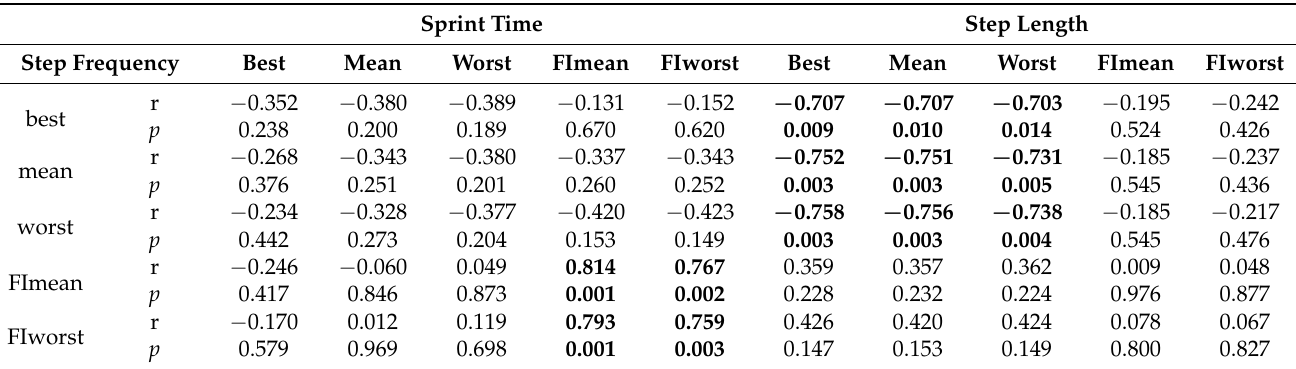
Table 3. Relationships between step frequency parameters (best, mean, worst, FImean, and FIworst) with sprint time and step length parameters (best, mean, worst, FImean, and FIworst) during